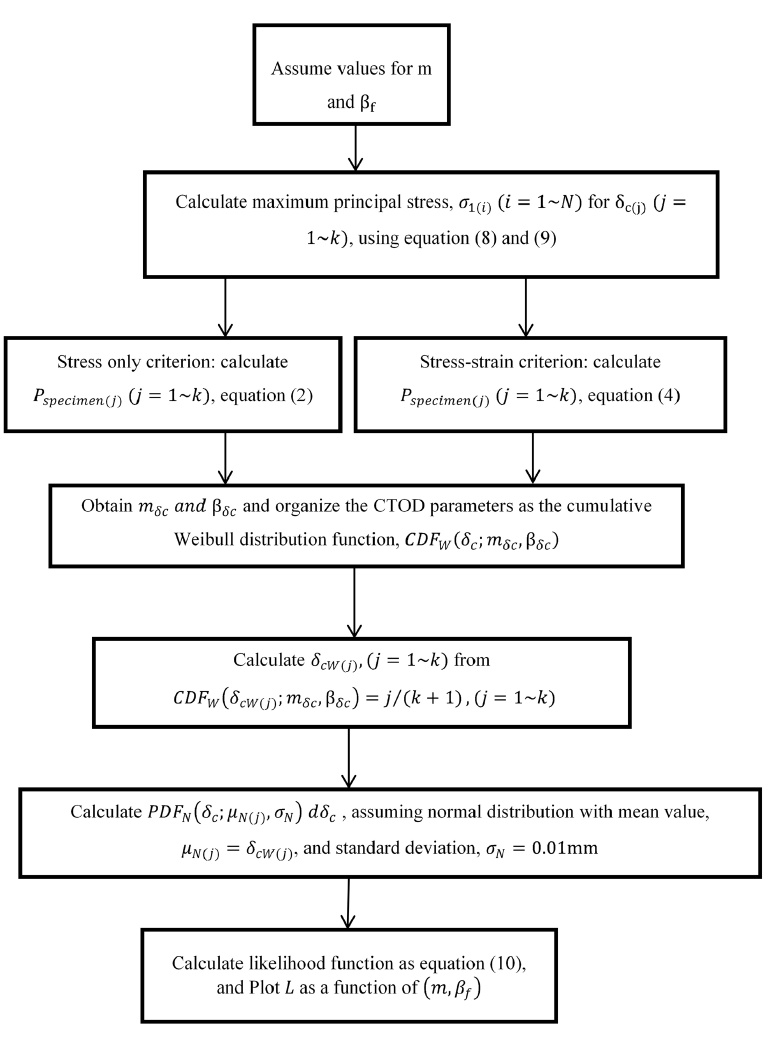
Figure 2. Flow chart of the procedure for likelihood function plot.